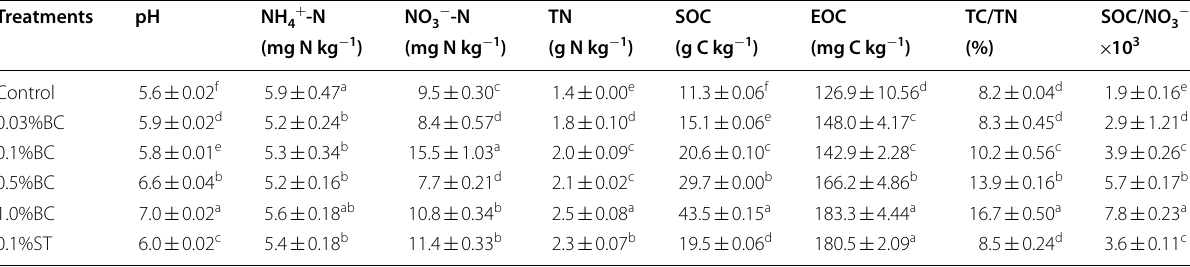
Data are expressed as the mean standard deviation ( n 3) ± = Means denoted by a different letter in the same column differ significantly according to one-way ANOVA ( P < 0.05) TC soil total carbon, TN soil total nitrogen, SOC soil organic carbon (including the organic carbon derived from biochar residue in the soil), EOC soil extractable organic carbon